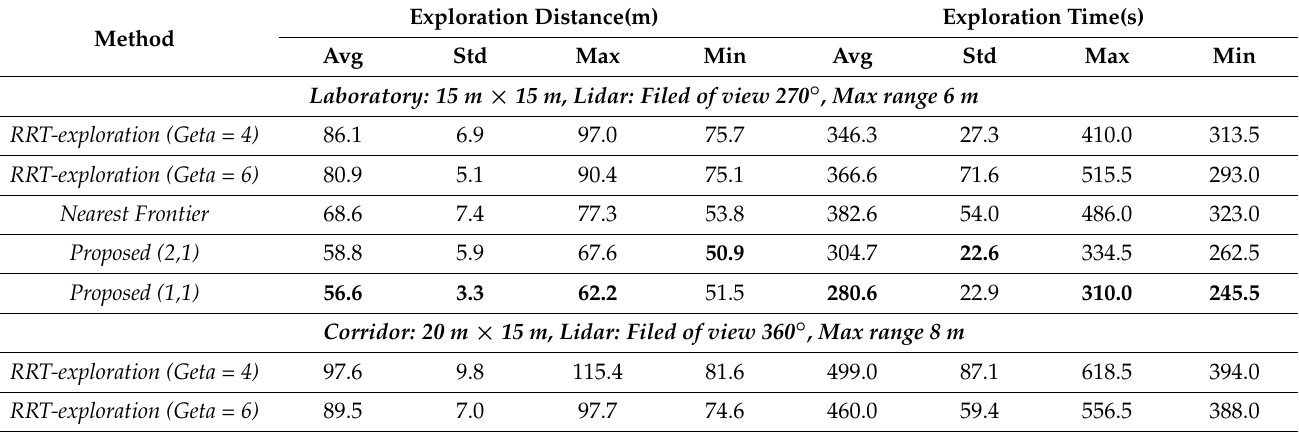
Table 3. Experimental data of different methods in three